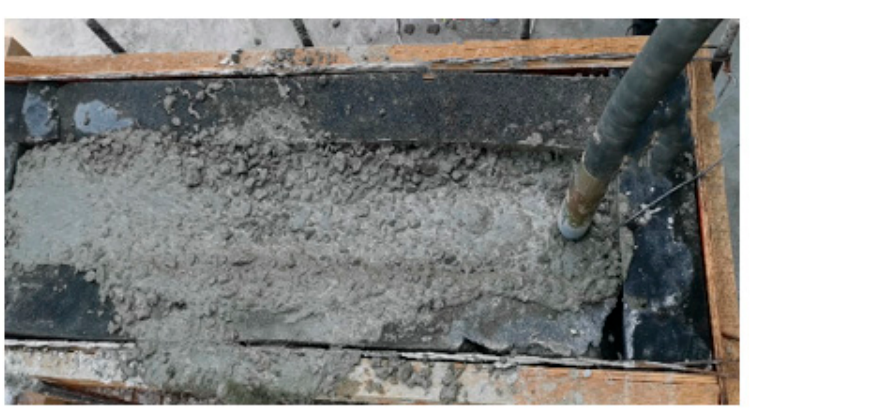
Figure 7. Actual test mold.